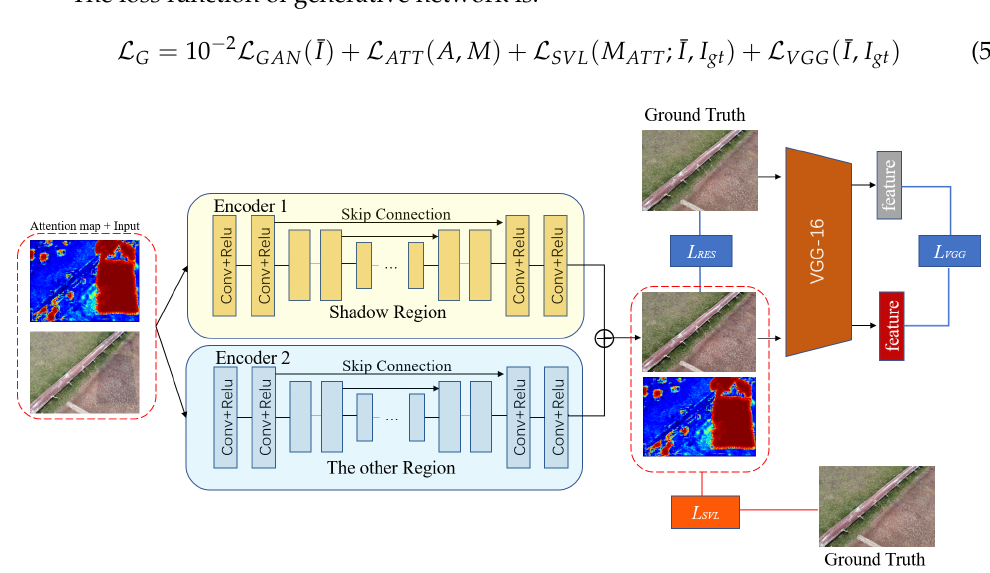
Figure 5. The architecture of the autoencoder. It contains two encoder-decoders with three skip connections. The final output will be used to compute L MSE , L RES , L SVL .